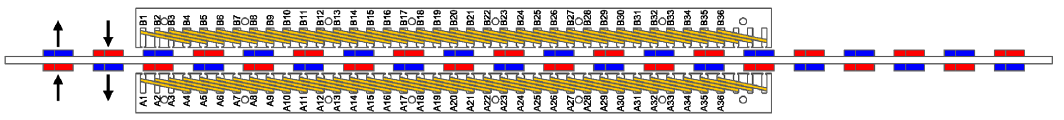
Figure 6. Magnetization of PM in the translator and position of coils in the stator.